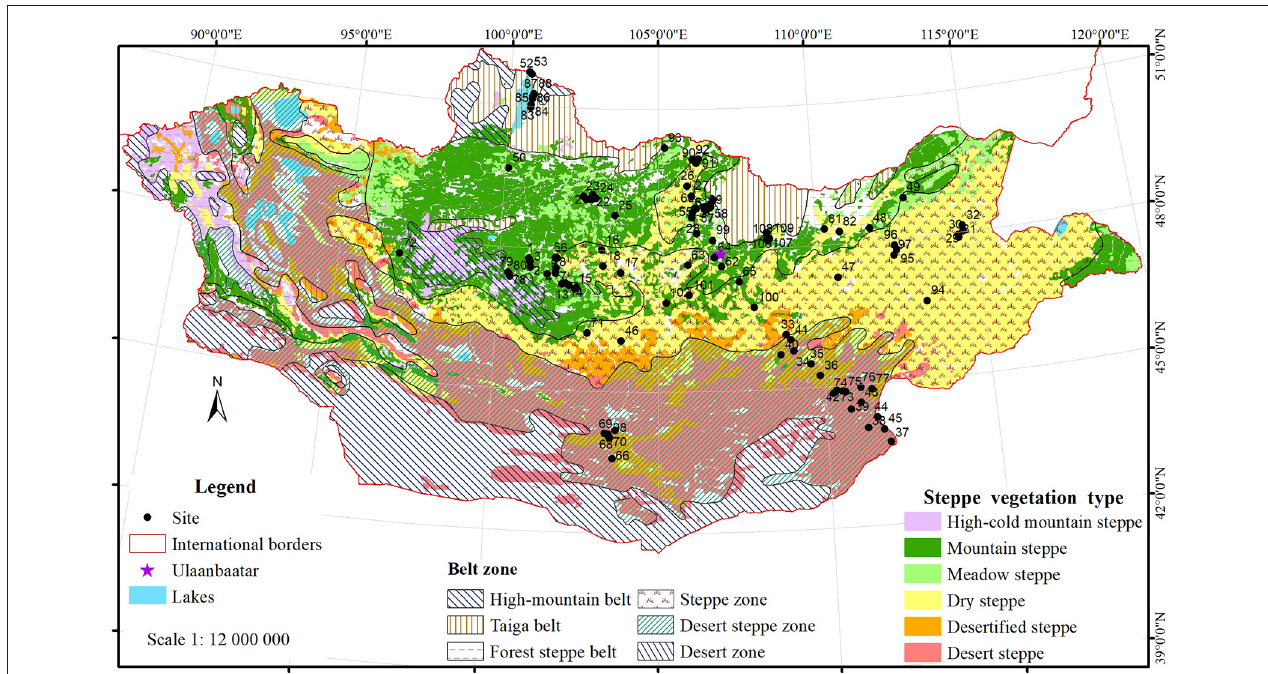
FIGURE 1 | Ecological zones and steppe vegetation types of Mongolia, with 109 study sites extracted from the reviewed publications. Ecological belt zones are based on the adapted vegetation map of the People’s Republic of Mongolia (Yunatov and Dashnyam, 1979; Ulziikhutag, 1985). Steppe vegetation types follow the Steppe Vegetation of Mongolia ( Tuvshintogtokh, 2015), and the “dry steppe” here includes “typical steppe,” as it is commonly done in literature. The high-cold mountain steppe is abbreviated as the high mountain steppe in the following. The sites located in the “desertified steppe” are grouped into the “desert steppe” in the analyses. The site ID is the same as in Supplementary Table A1 .